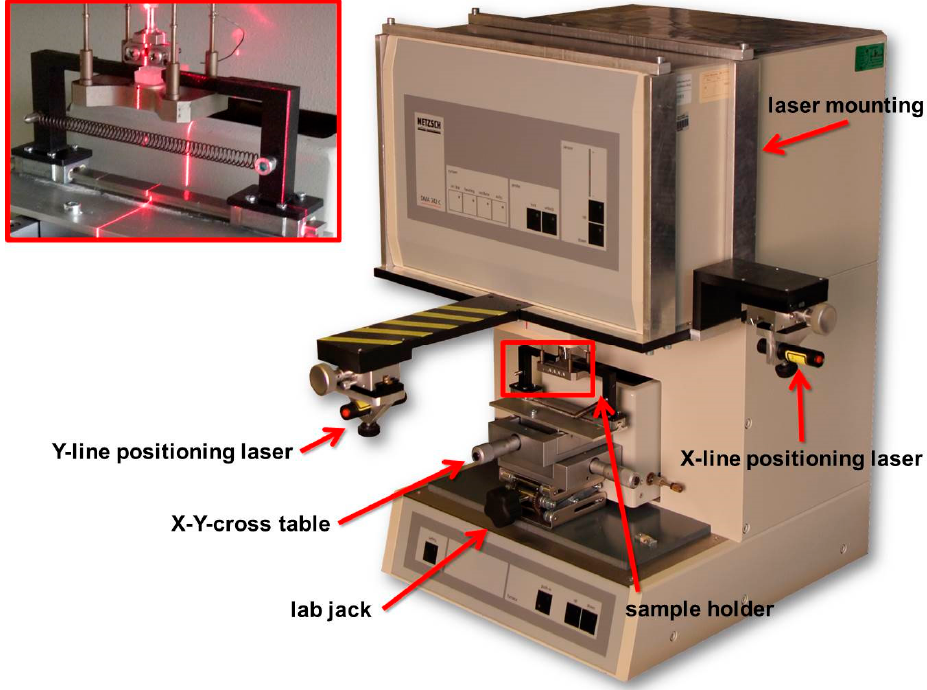
Figure 3. Specially developed x-y-stage with a laser positioning system for spatial resolution of microindentations.